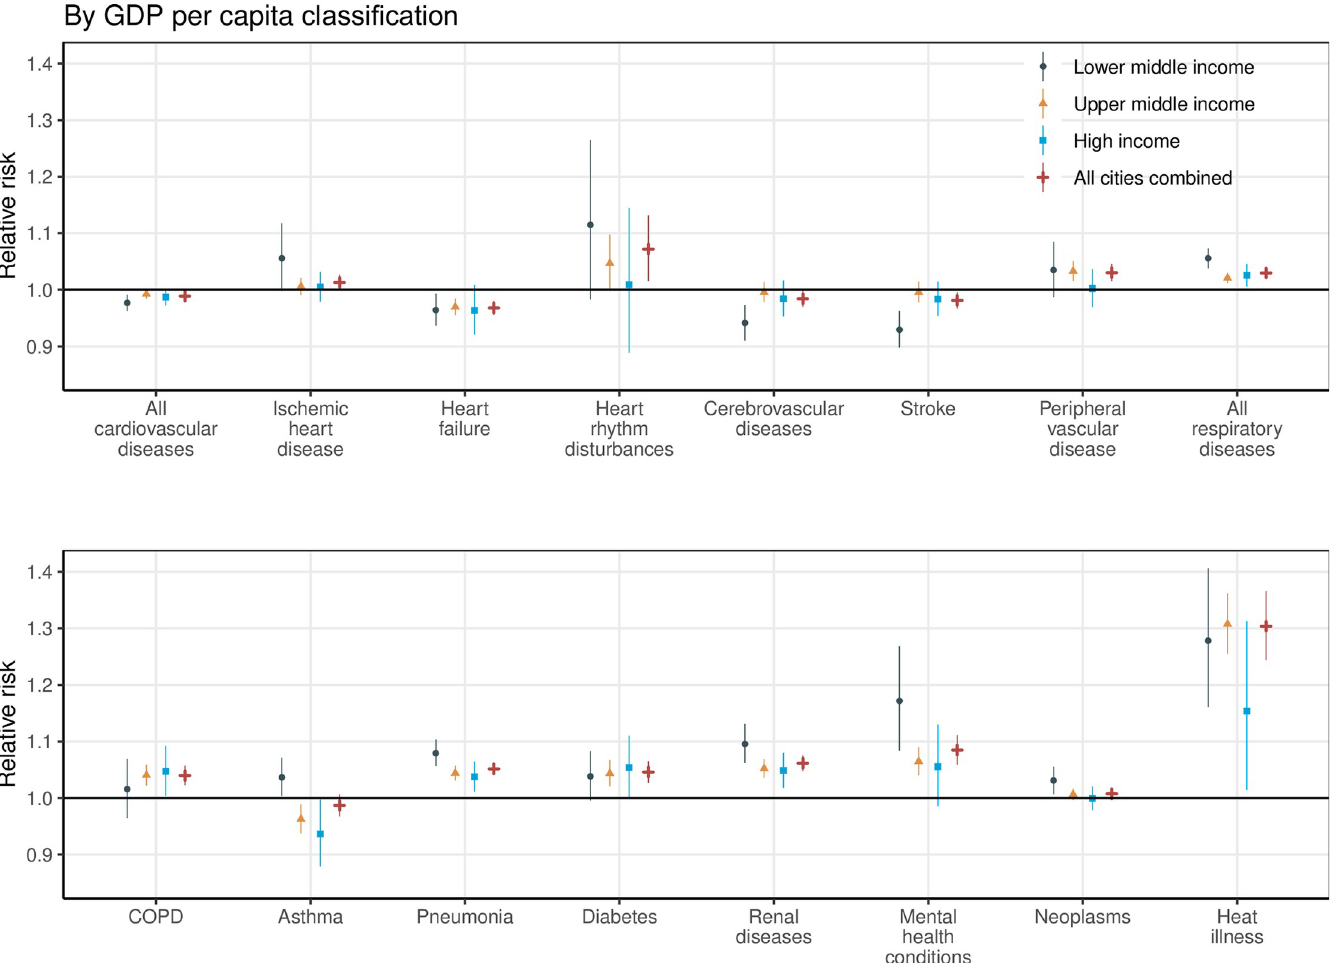
Fig 4. The association between heat exposure (for every 5˚C increase in daily mean temperature) and cause-specific hospitalization during lag 0–7 days, stratified by GDP per capita classification. GDP per capita classifications were based on the World Bank’s 2015 standard. COPD, chronic obstructive pulmonary disease; GDP, gross domestic